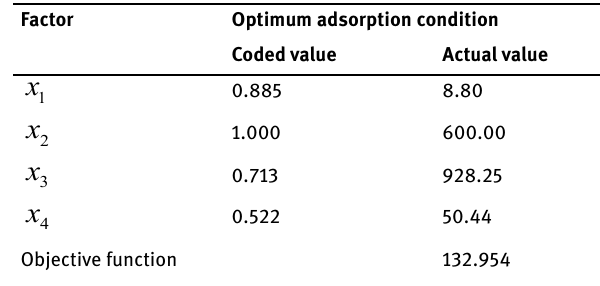
Table 6: Optimum adsorption solution of the optimization model in Equation